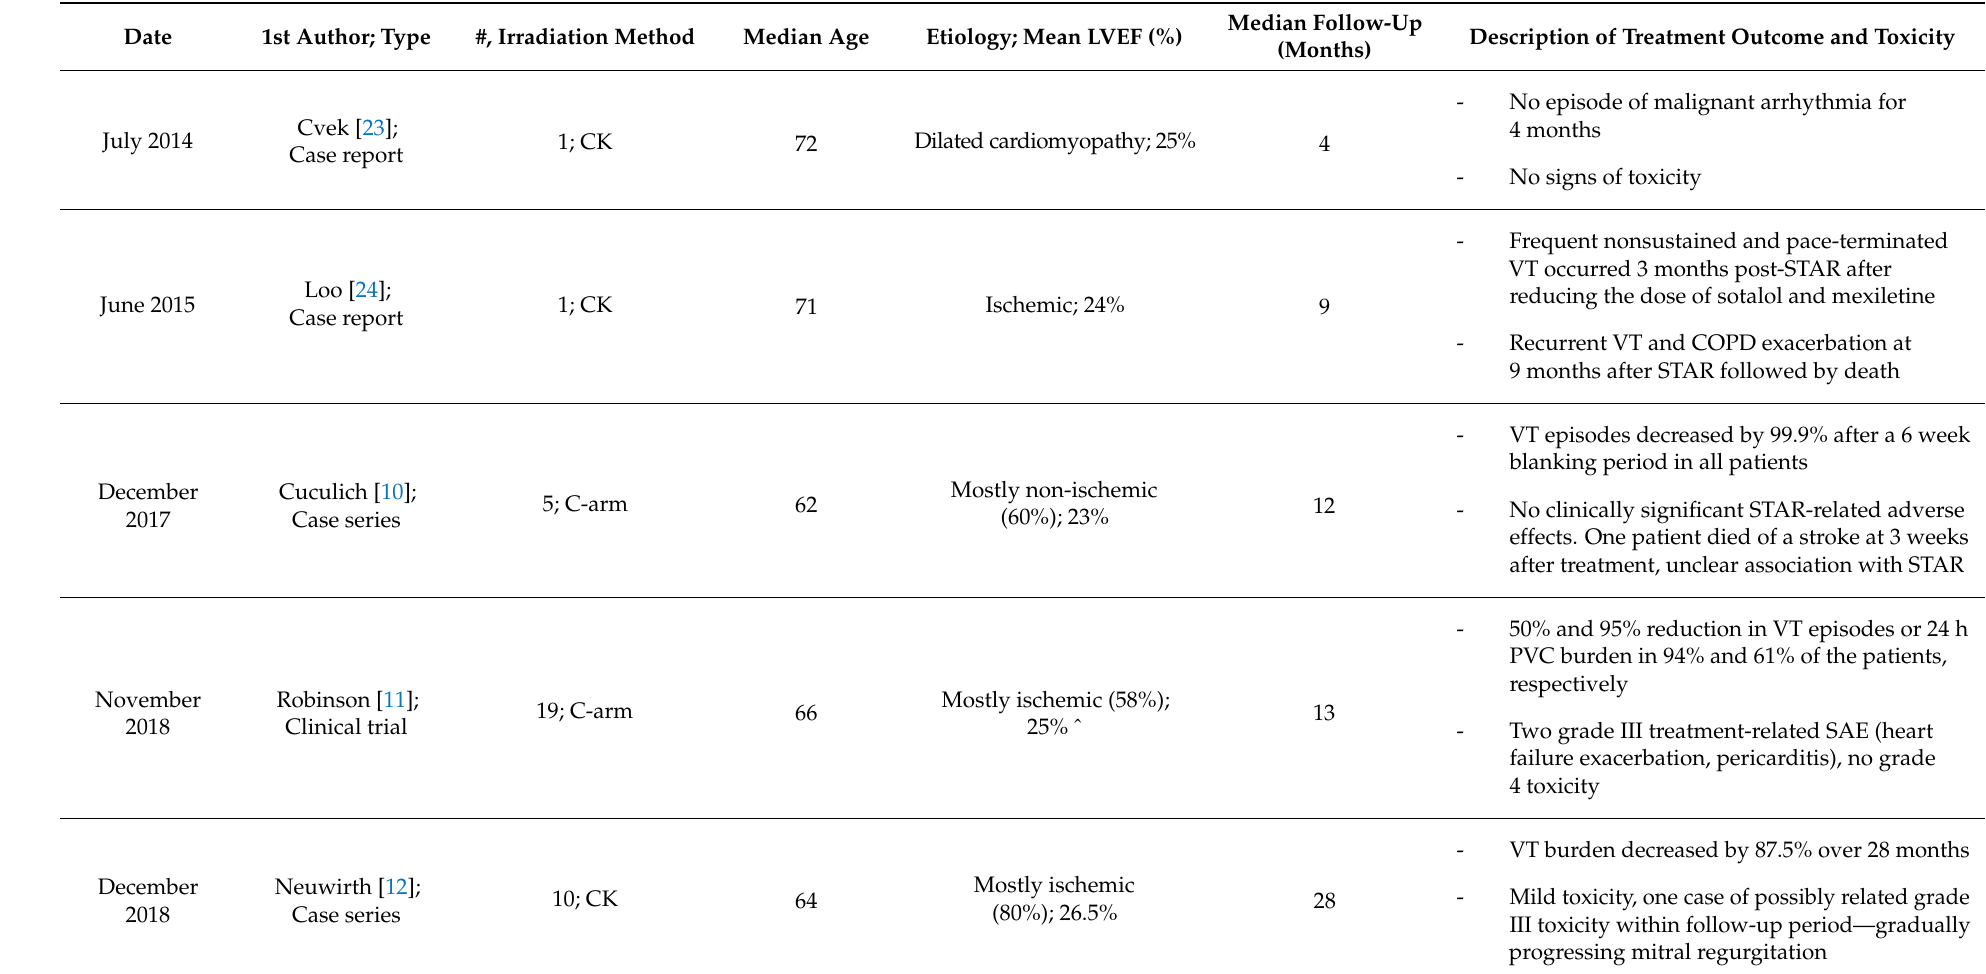
Table 1. Clinical data on stereotactic arrhythmia radioablation